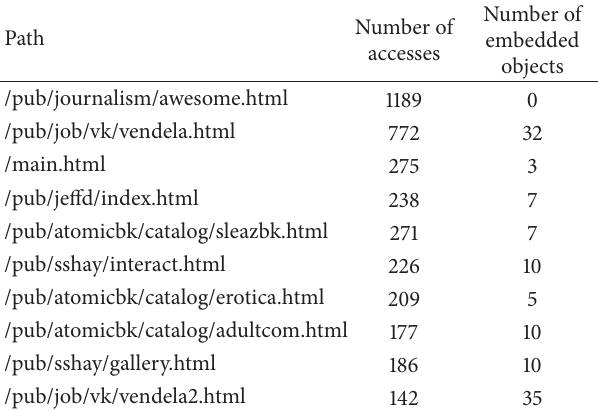
Table 4: Analysis of web objects (ClarkNet).